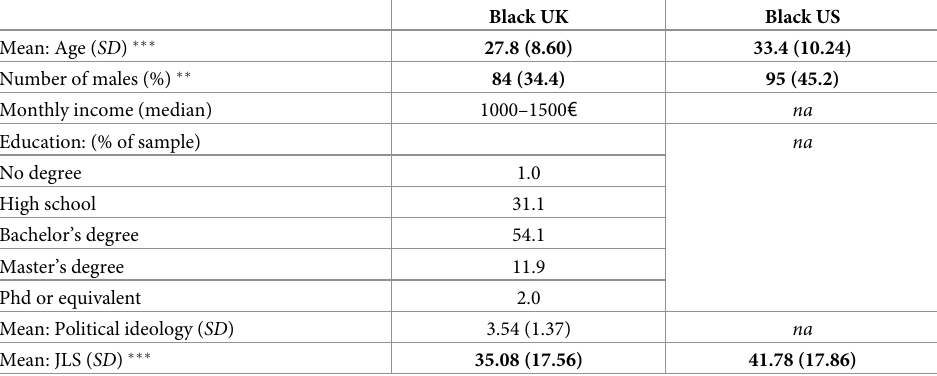
Table 1. Descriptive statistics for black UK and US samples (Study